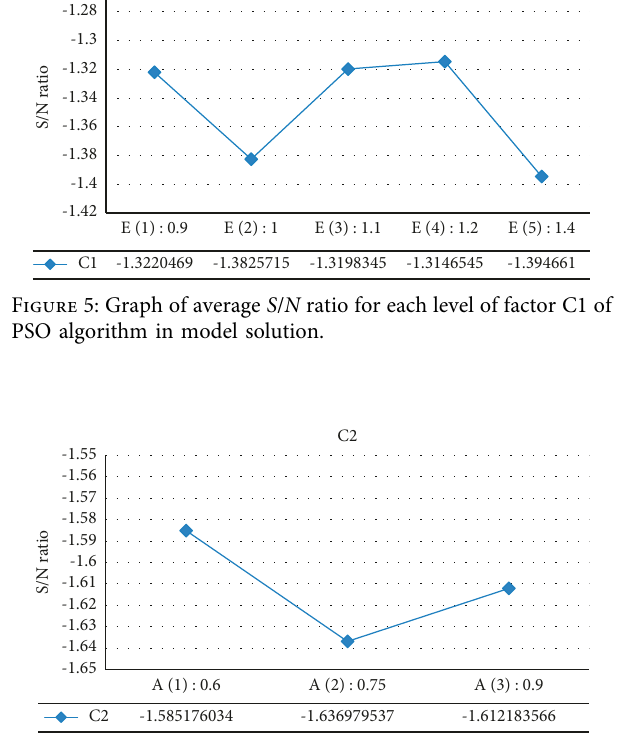
Figure 6: Graph of average S / N ratio for each level of factor C2 of PSO algorithm in model solving.